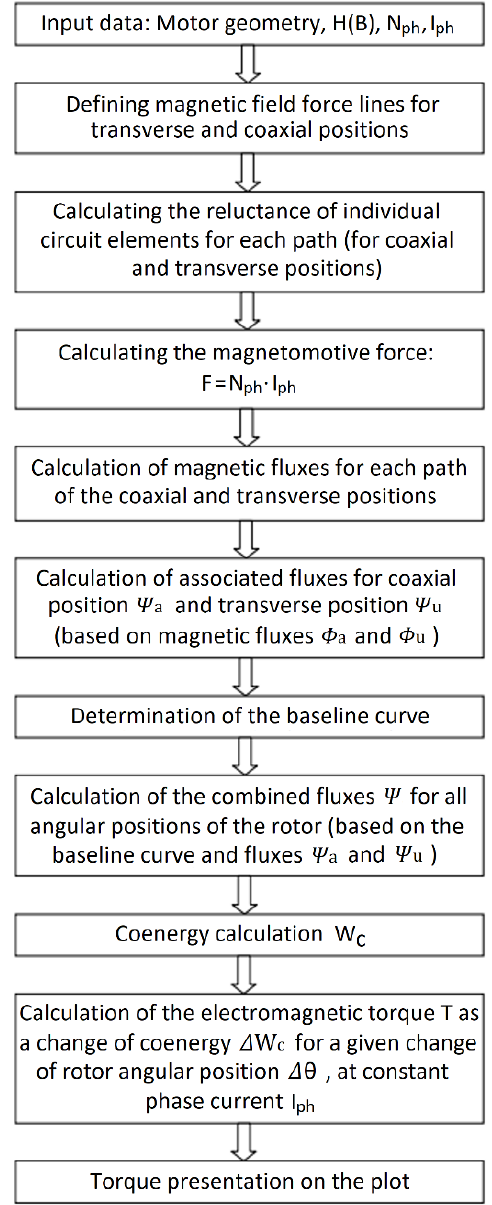
Figure 5. The scheme of performing calculations by the implemented analytical